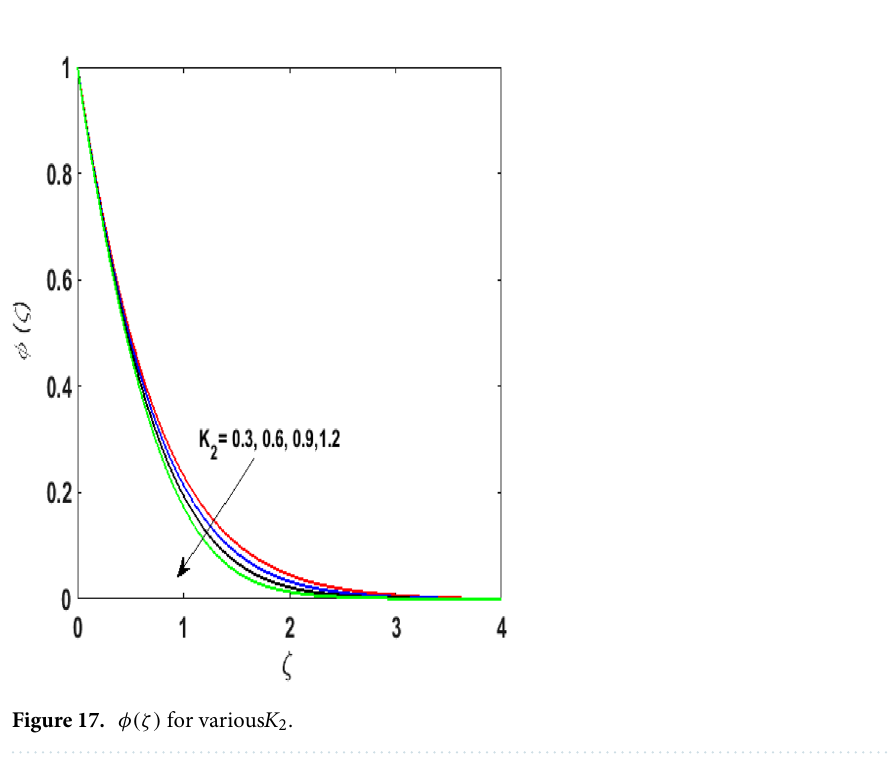
Figure 16. φ(ζ) for various E .